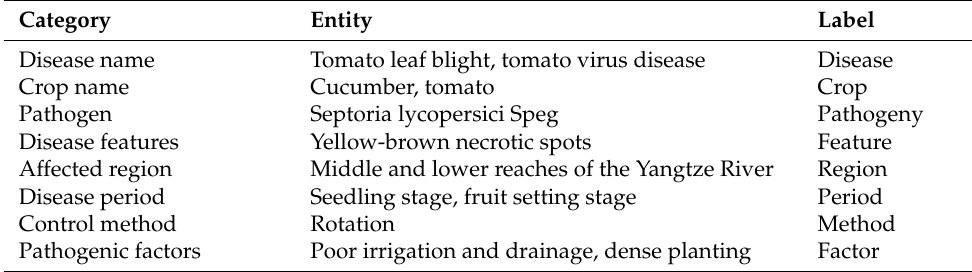
Table 1. Labels for named-entity